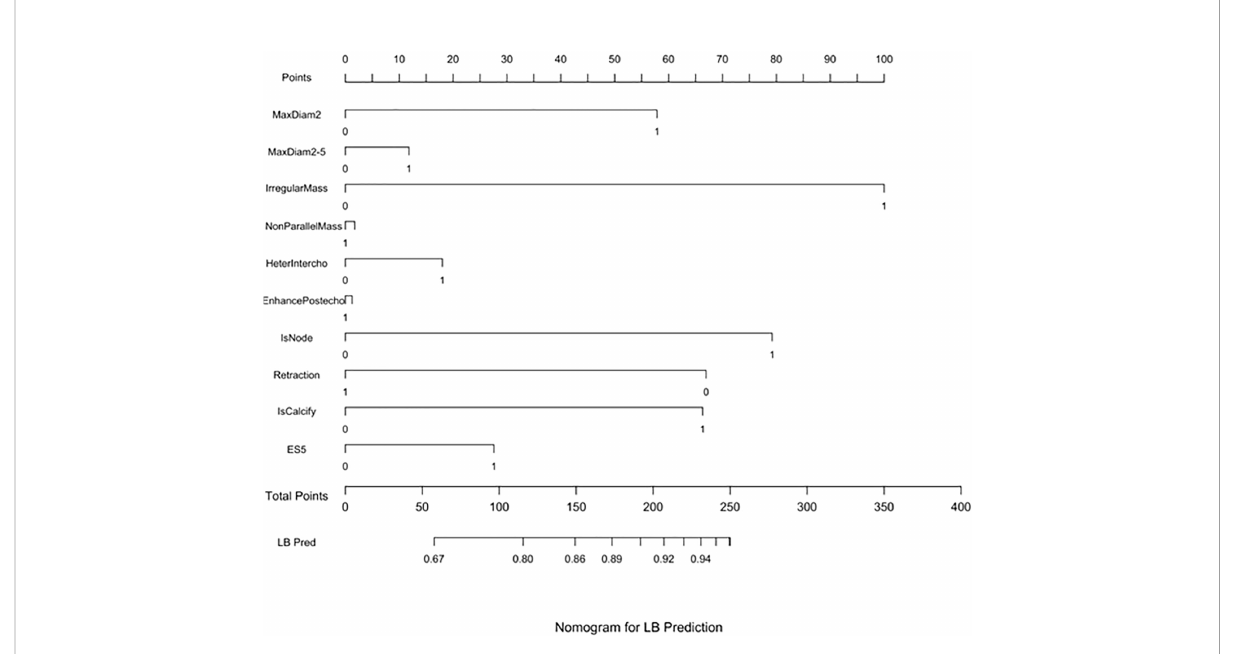
FIGURE 1 LB prediction nomogram. Nomograms were constructed based on the results of the multivariate logistic regression mode